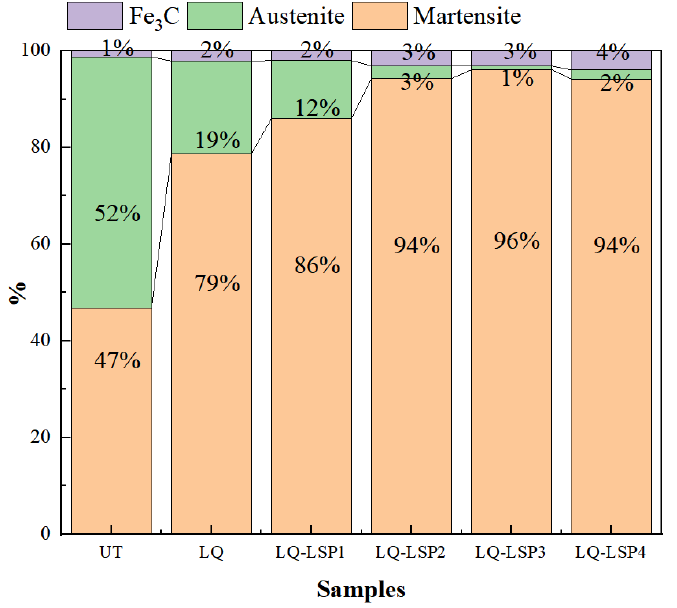
Figure 7. Distribution of phase content of samples after different processes .